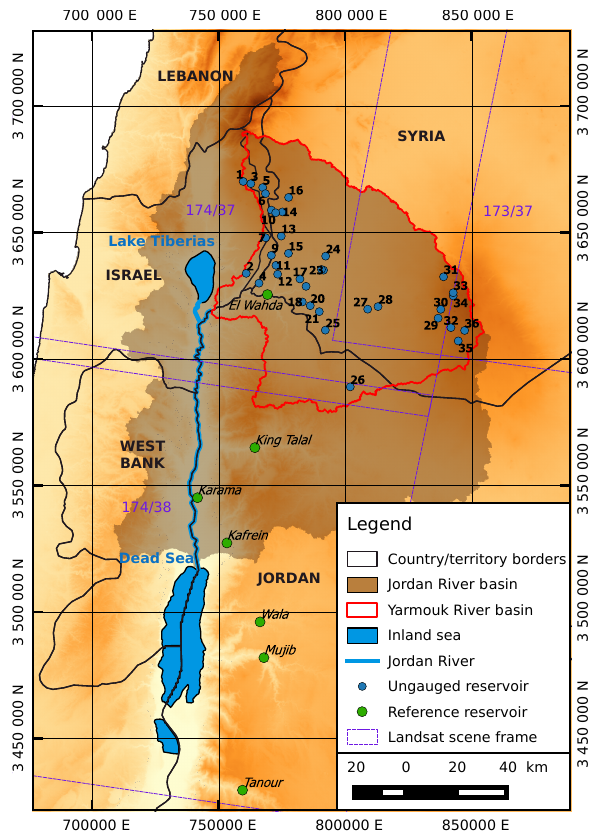
Figure 1. Reservoirs identified in Jordan and the Yarmouk River basin using the method developed in this paper. Because in situ mea- surements are accessible for those managed by Jordan, they are used to validate the method. Coordinates are expressed in the Coordinate Reference System (CRS) WGS 84/UTM zone 36N (EPSG:32636), in which 1 unit equals 1m.